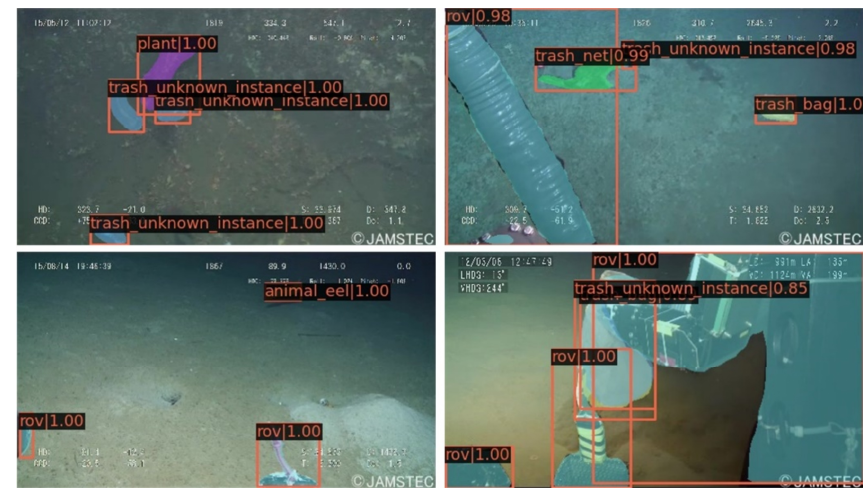
Figure 9. Visualization of our model in performance testing.